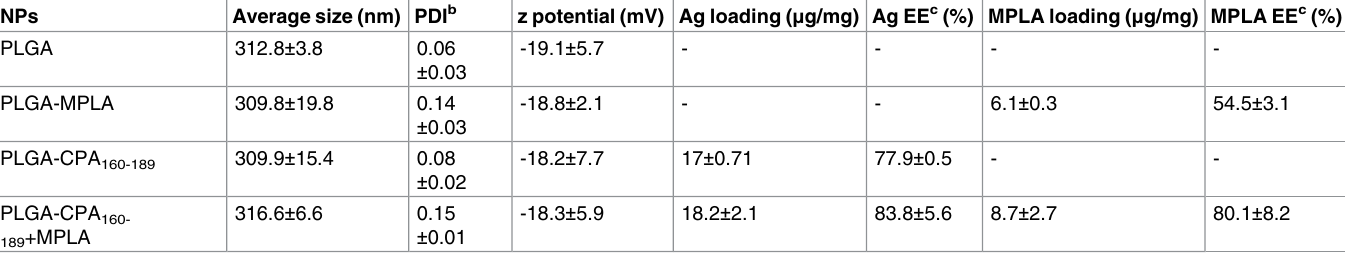
Table 2. Properties of synthesized PLGA NPs. a